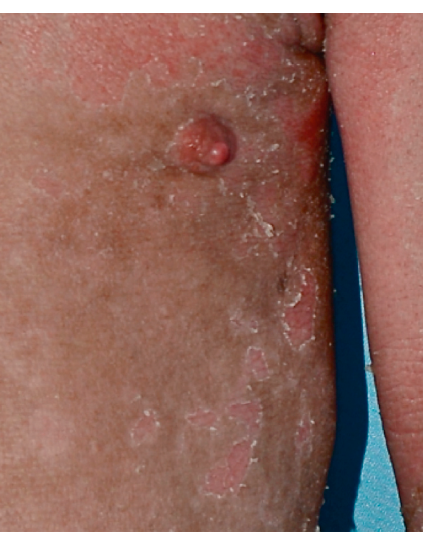
Figure 1: Serpiginous, erythematous plaques with double-edged peripheral scale.